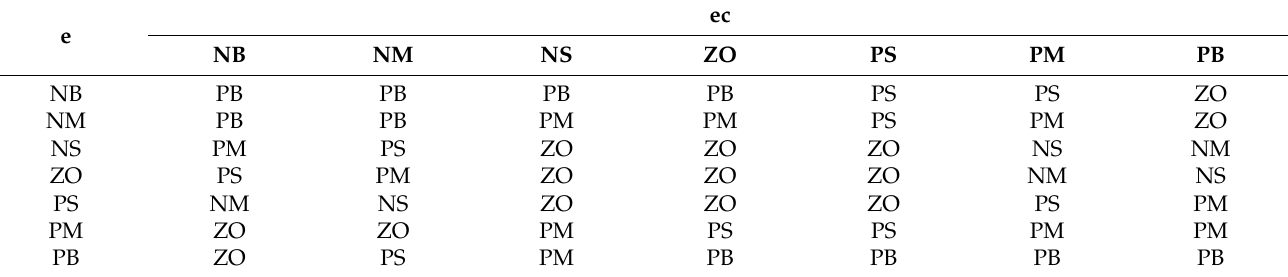
Figure 9. Spatial distribution of △ Ki.